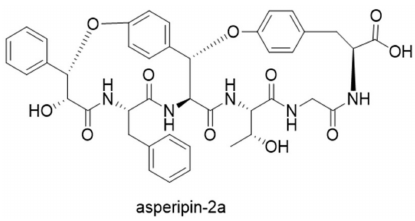
Figure 10. Structure of asperipin-2a.